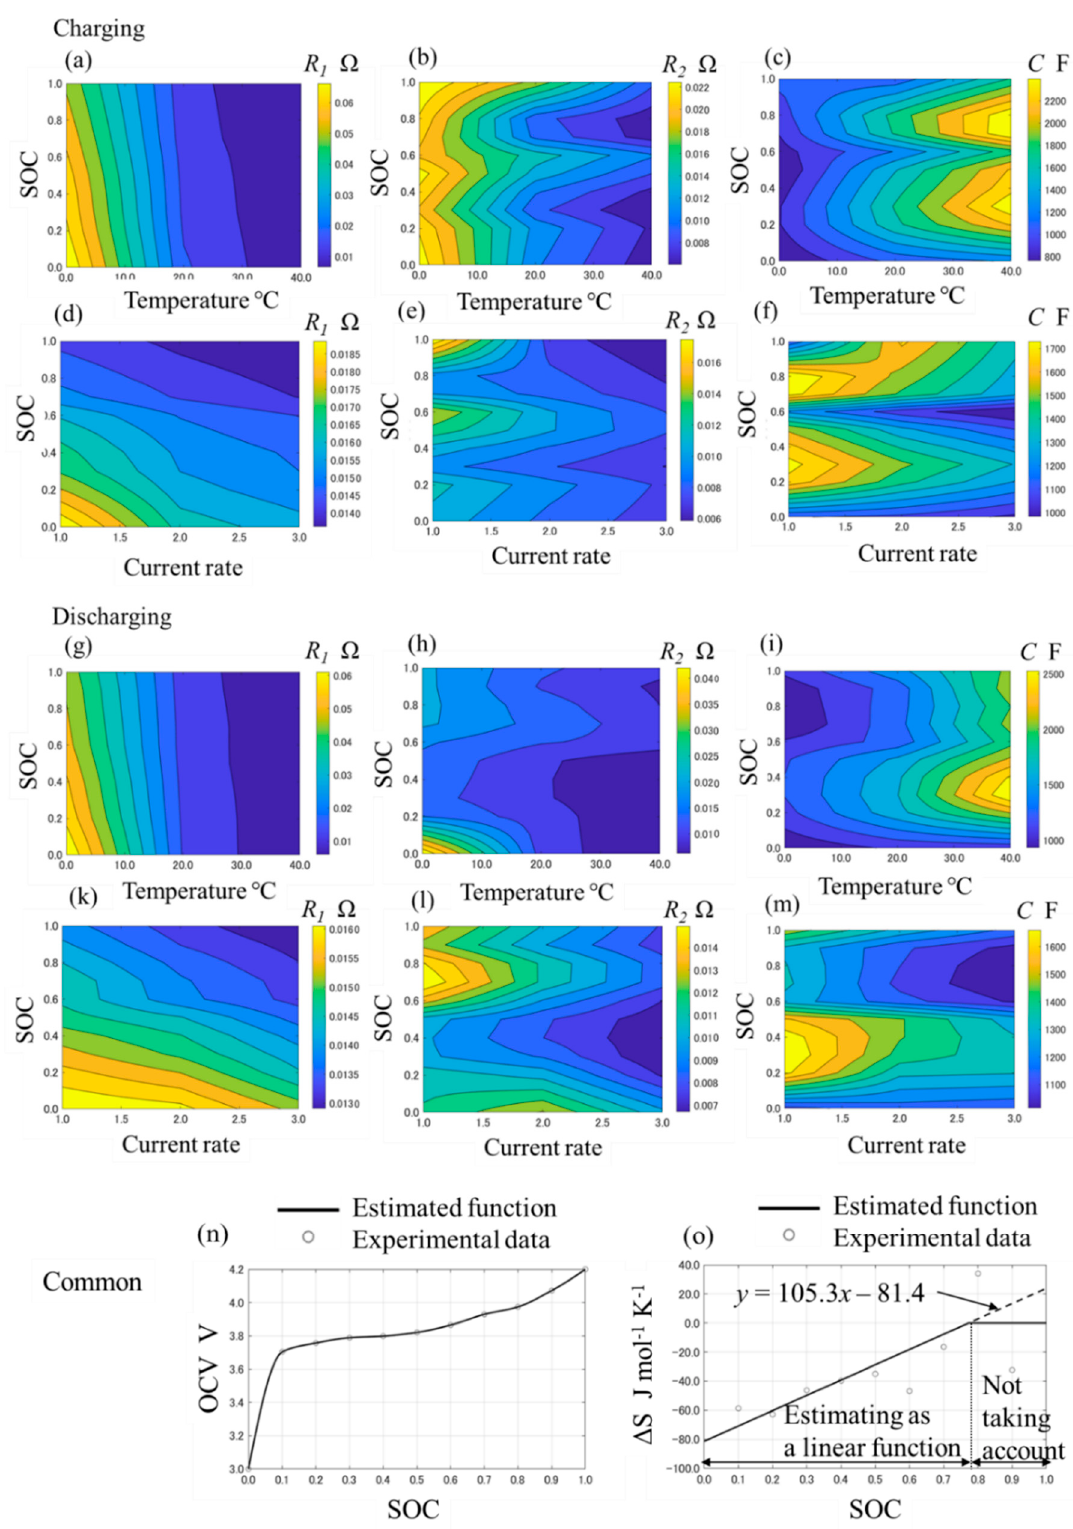
Figure 2. The relationship between the variable parameters and the arguments in the electrical ECM. ( a – f ) show the relationship between R 1 , R 2 , C and temperature, current, state of change (SOC) at charge, ( g – m ) show it at discharge, ( n ) shows the relationship between SOC and open-circuit voltage (OCV) , and ( o ) shows the relationship between SOC and Δ S .